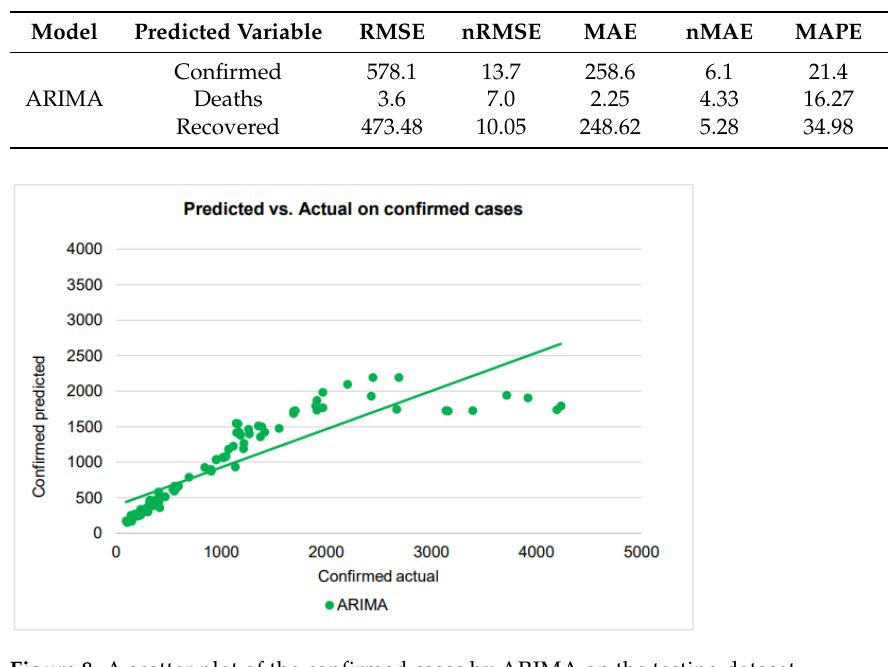
Figure 8. A scatter plot of the confirmed cases by ARIMA on the testing